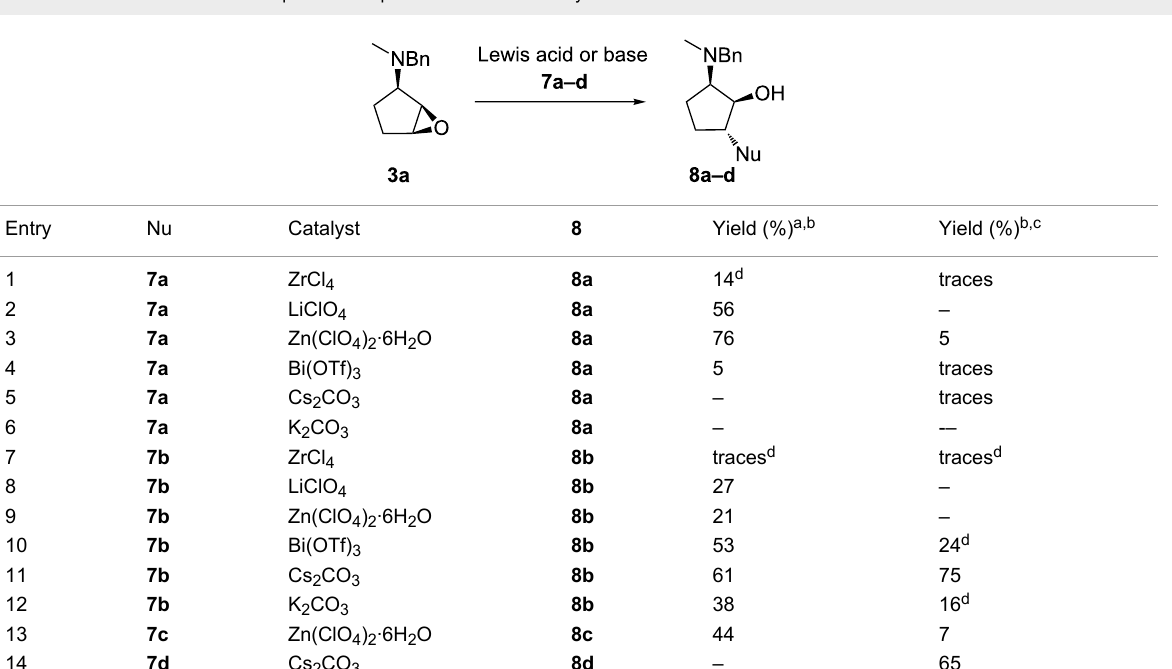
Table 1: Reactions of 3a with nucleophiles in the presence of various